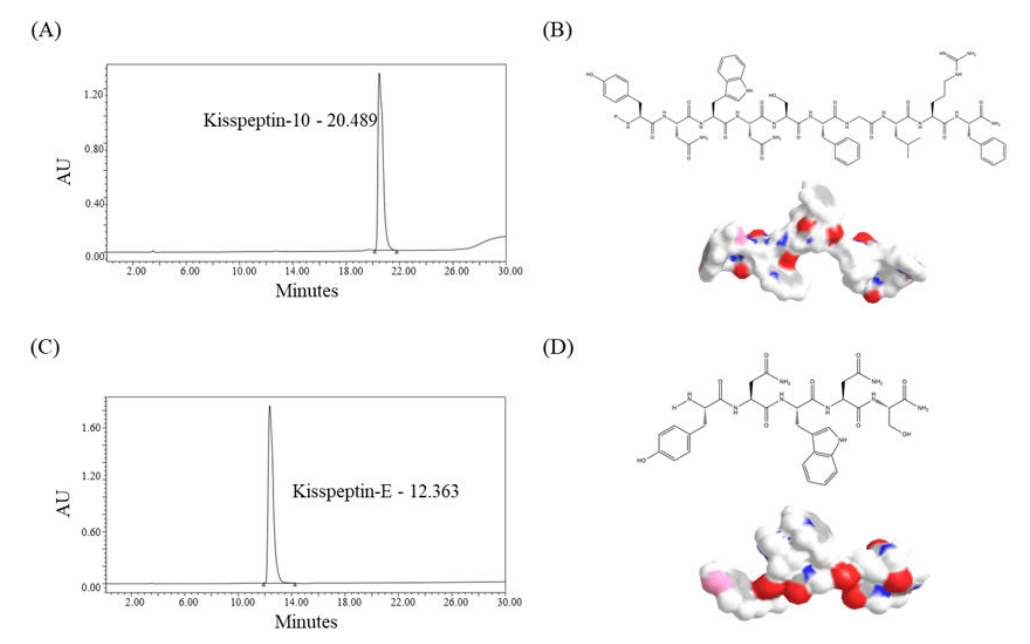
Figure 1. Characterization of Kisspeptin-mimicking peptides. The HPLC elution times were measured to confirm ( A ) Kisspeptin-10 and ( C ) Kisspeptin-E. The chemical structures and 3D rendering of the mimicking peptides represent ( B ) Kisspeptin-10 and ( D )